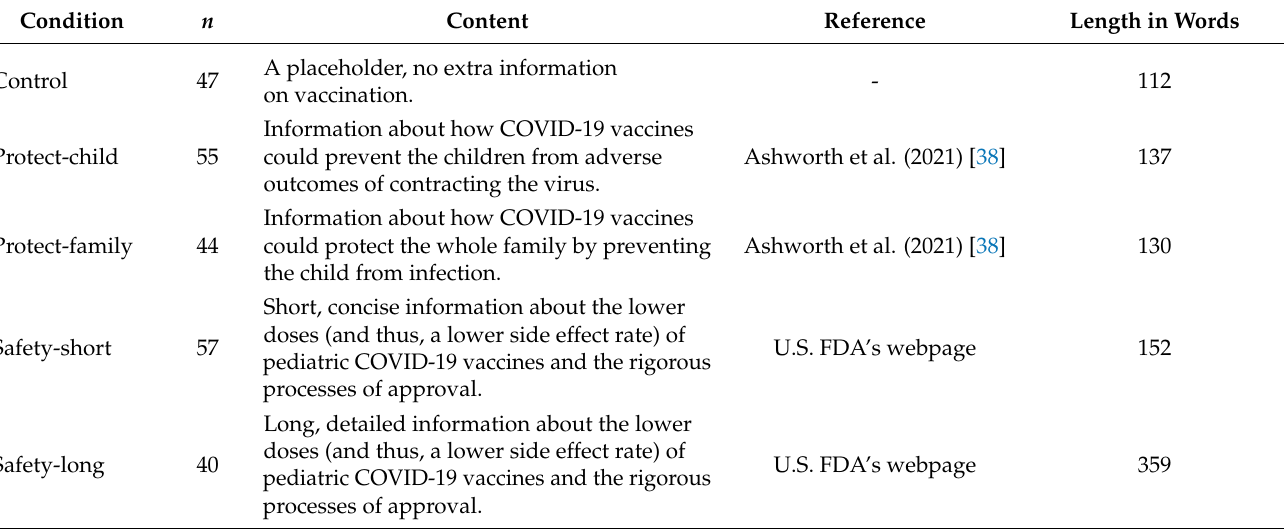
Table 1. Overview of message content in experimental